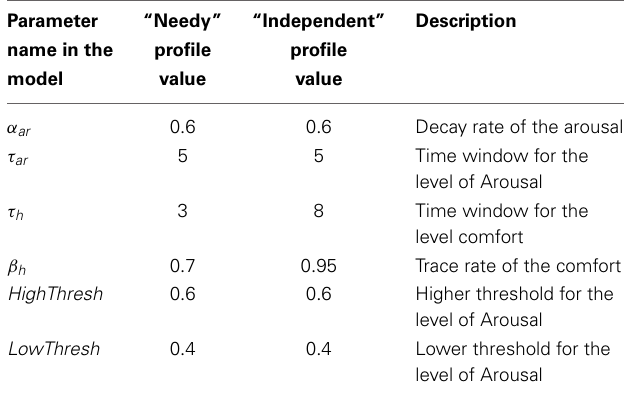
Table 1 | Parameters used in the experiment for the “needy” and the “independent” robot profiles.